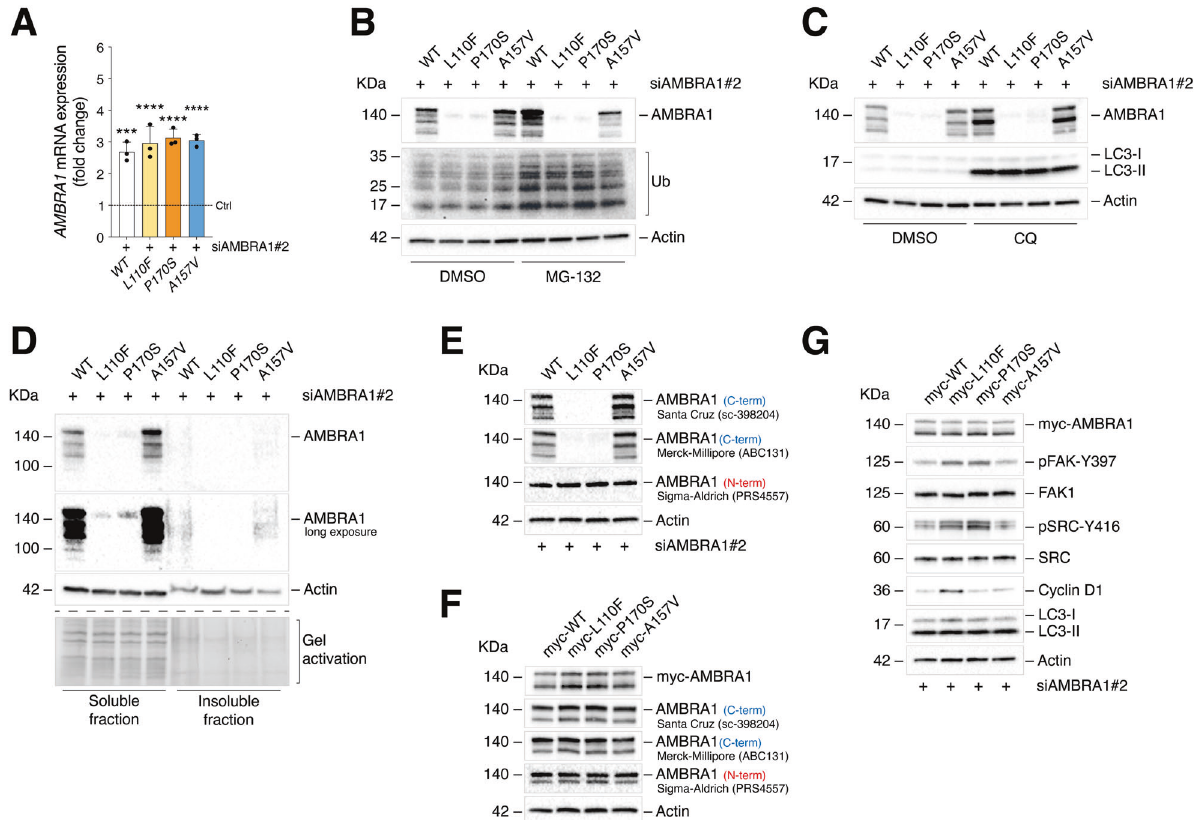
Fig. 4 Analysis of the role of L110F and P170S mutants on AMBRA1 stability. A RT-qPCR analyses of AMBRA1 upon WT, L110F, P170S, and A157V re-expression. Data were normalized on L34 and expressed as fold change vs non-transfected cells (Ctrl, indicated by a dashed line) ± SEM ( n = 3; *** p = 0.0002; **** p < 0.0001; one-way ANOVA). B 24 h after transfection of the constructs, A375 cells were treated with MG- 132 (10 µM) or C CQ (40 µM) for 4 h and WB analyses for AMBRA1 and Actin performed. Ubiquitylated proteins (Ub) and LC3-II accumulation were detected as positive controls for the treatments. Images are representative of n = 4 independent experiments. D WB analyses of soluble and insoluble fractions upon mutant re-expression. AMBRA1 and Actin were detected ( n = 3). A representative gel activation is also shown. E WB analyses of AMBRA1 upon WT, L110F, P170S, and A157V re-expression in A375 and F upon re-expression of AMBRA1-myc-tagged constructs using a panel of anti-AMBRA1 antibodies. In F , AMBRA1 has been revealed also using an anti-myc antibody. G A375 cells were re- expressed with AMBRA1-myc-tagged WT, L110F, P170S and A157V constructs and pFAK-Y397, FAK1, pSRC-Y416, SRC, Cyclin D1, and LC3 (-I and -II) detected by WB. AMBRA1 was detected using an anti-myc antibody. In E – G Actin was revealed as loading control and images are representative of n = 3 independent